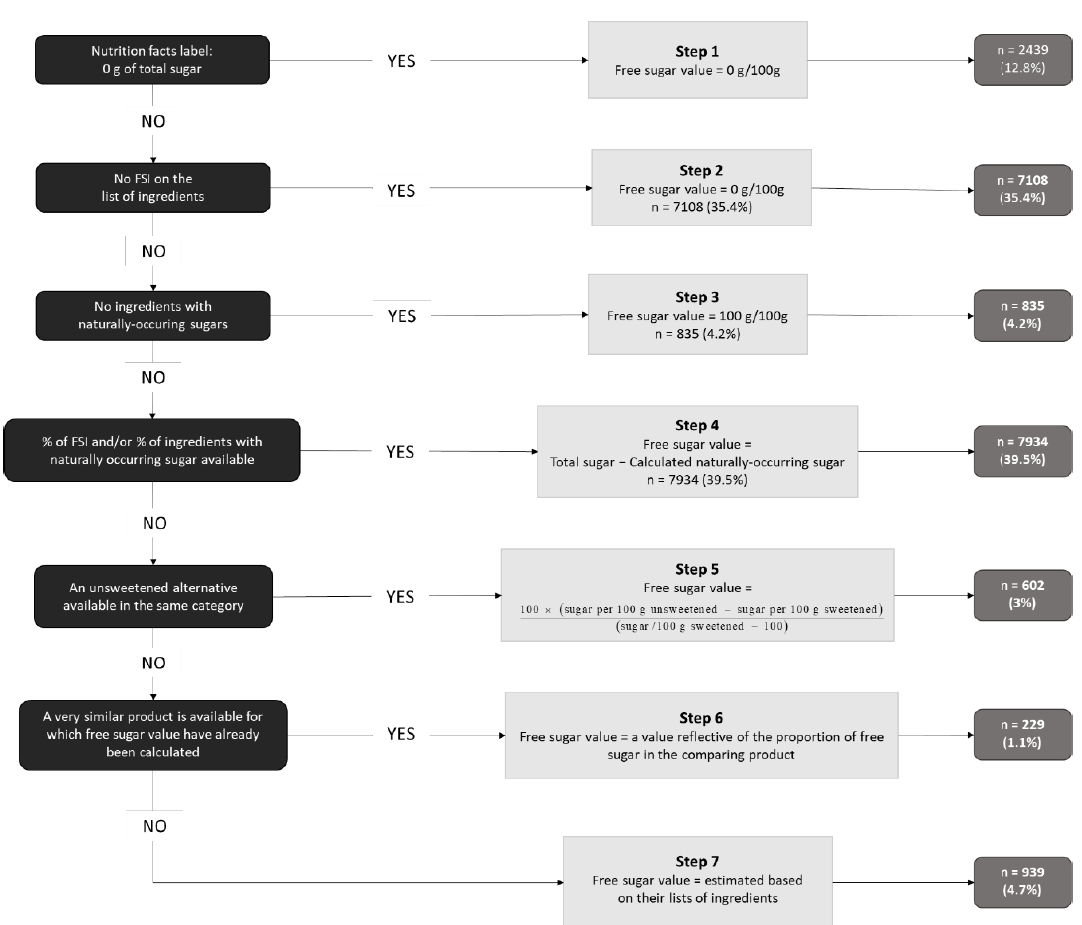
Figure 1. The decision tree algorithm used to estimate the free sugar content of packaged foods. The method was a modified version of the algorithm developed by Bernstein and colleagues [18] and has been implemented in our previous database analyses [12]. n (%) indicates the number and proportion of products included at each step.